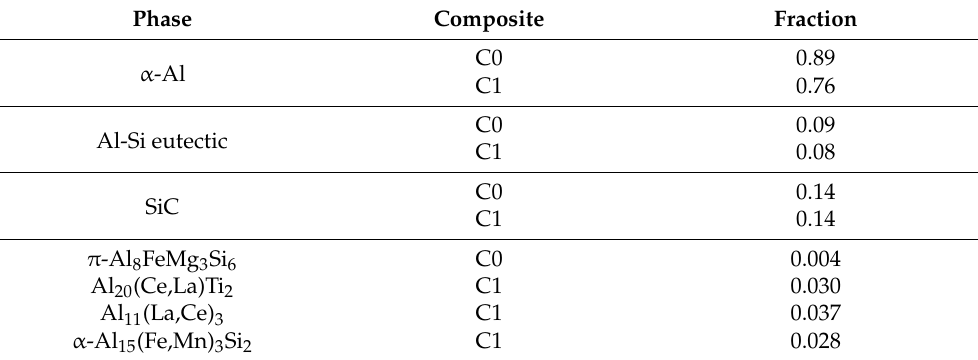
Table 4. Fraction of phases, calculated by Thermocalc, formed in the matrix alloys of materials C0 and C1.